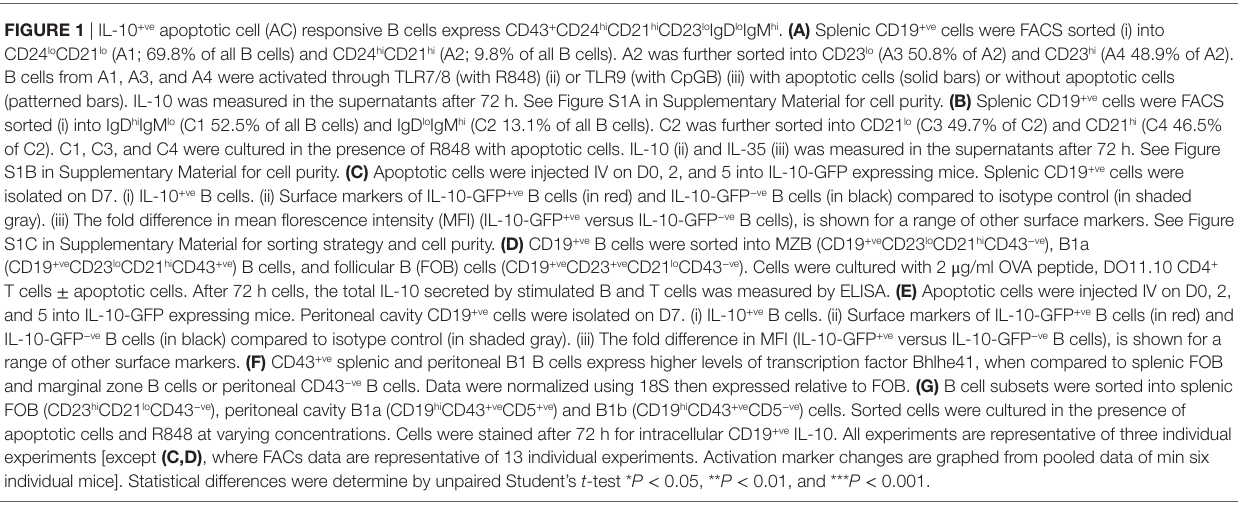
FigUre 1 | IL-10 + ve apoptotic cell (AC) responsive B cells express CD43 + CD24 hi CD21 hi CD23 lo IgD lo IgM hi . (a) Splenic CD19 + ve cells were FACS sorted (i) into CD24 lo CD21 lo (A1; 69.8% of all B cells) and CD24 hi CD21 hi (A2; 9.8% of all B cells). A2 was further sorted into CD23 lo (A3 50.8% of A2) and CD23 hi (A4 48.9% of A2). B cells from A1, A3, and A4 were activated through TLR7/8 (with R848) (ii) or TLR9 (with CpGB) (iii) with apoptotic cells (solid bars) or without apoptotic cells (patterned bars). IL-10 was measured in the supernatants after 72 h. See Figure S1A in Supplementary Material for cell purity. (B) Splenic CD19 + ve cells were FACS sorted (i) into IgD hi IgM lo (C1 52.5% of all B cells) and IgD lo IgM hi (C2 13.1% of all B cells). C2 was further sorted into CD21 lo (C3 49.7% of C2) and CD21 hi (C4 46.5% of C2). C1, C3, and C4 were cultured in the presence of R848 with apoptotic cells. IL-10 (ii) and IL-35 (iii) was measured in the supernatants after 72 h. See